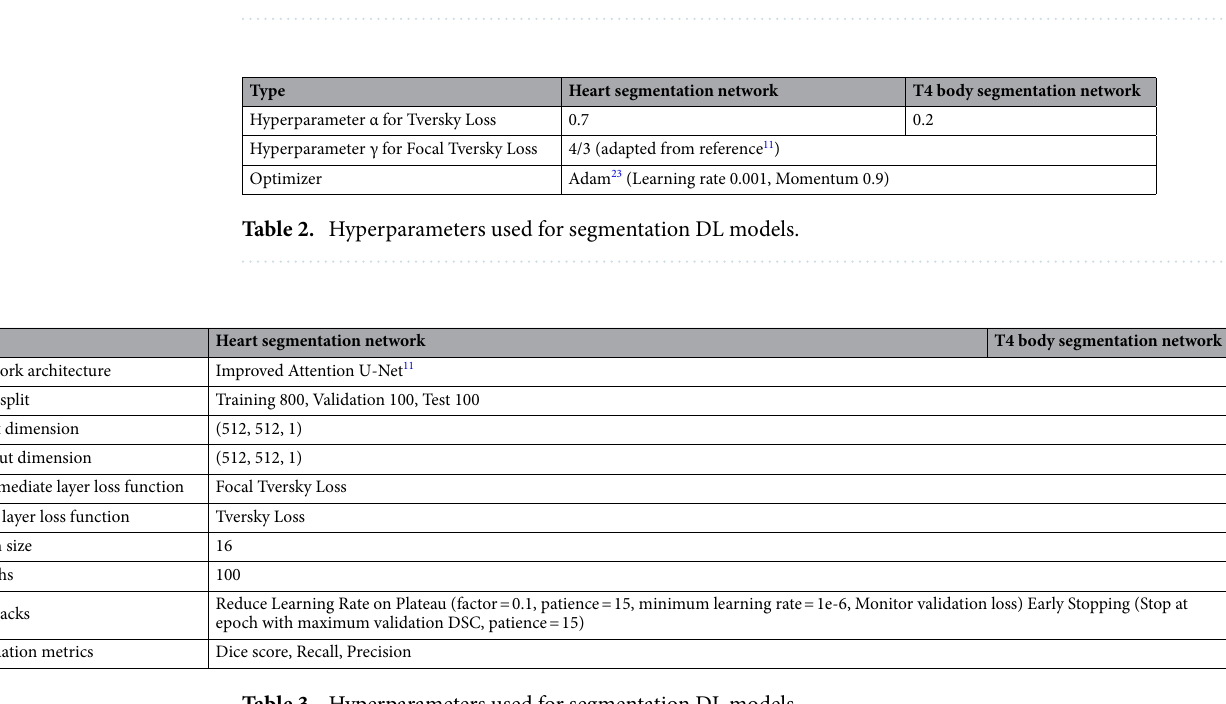
Table 1. General characteristics of the participating dogs. *Radiographs with report of “possible cardiomegaly” or “rule out mitral valve insufficiency (R/O MVI)”.